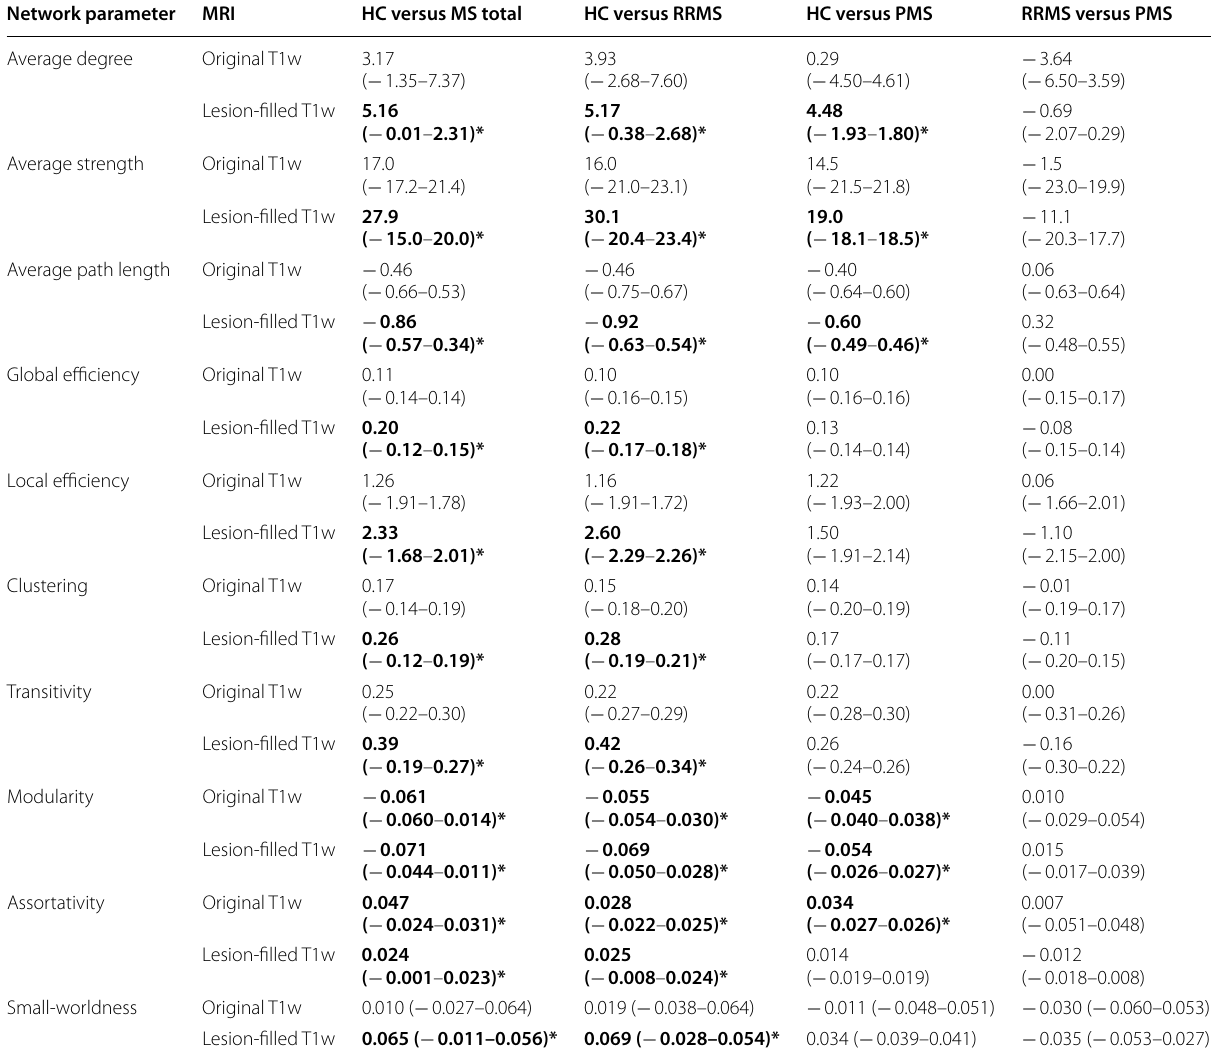
Differences relative to the healthy controls are statistically significant when the differences fall outside the 95% CI. Significant differences are indicated with an asterisk *. No statistically significant differences were observed between the RRMS and PMS group